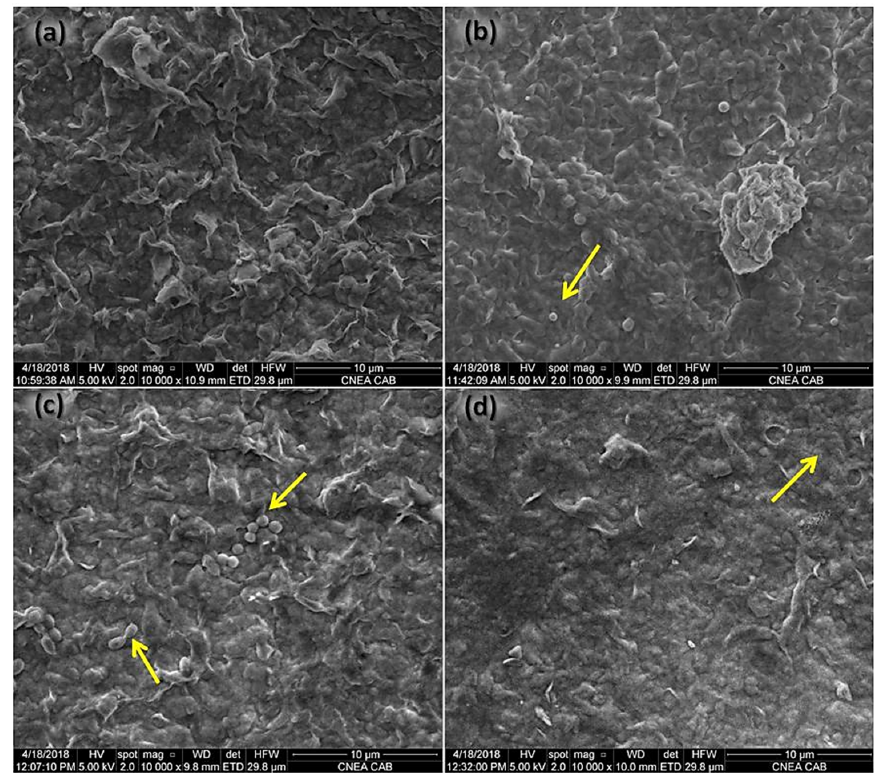
Figure 9. Scanning electron microscopy images of biofilm formation onto the reference clay montmorillonite. ( a ) Control without microorganisms; and biofilm formation after successive growing cycles I ( b ), II ( c ) and III ( d ). The surface of montmorillonite particles after eight days of culture (Cycle II) was covered by the biofilm (see the text for further explanations). The arrows in ( a – c ) indicate different microbial morphologies (cocci and bacilli).